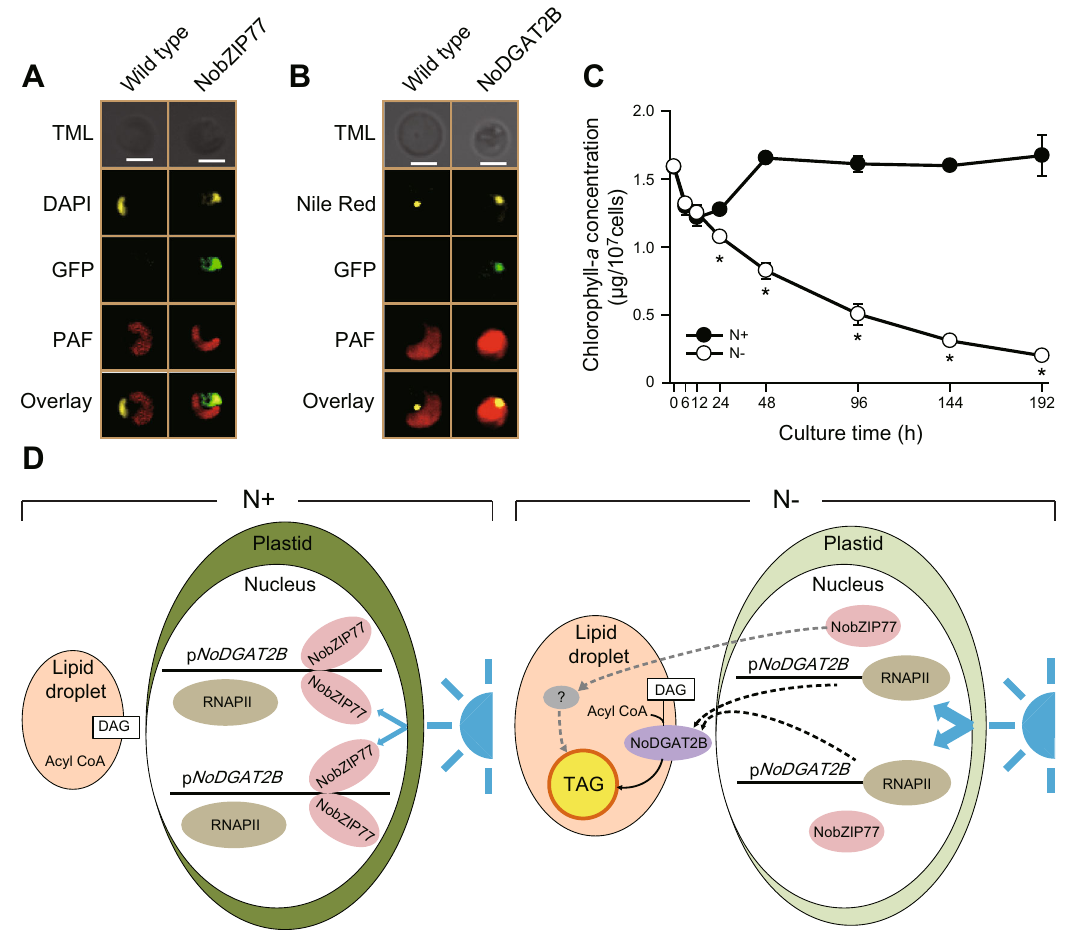
Fig. 4 A working model of nitrogen-depletion-induced TAG synthesis in Nannochloropsis oceanica . A , B Subcellular localization of NobZIP77 ( A ) and NoDGAT2B ( B ). GFP, green fl uorescent protein; TML, transmission light; DAPI, 4 ’ ,6-diamidino-2-phenylindole; PAF, plastid auto fl uorescence; scale bar, 2 μ m. The experiments were repeated three times. C Chlorophyll a levels in the N. oceanica WT under N + and N − . Data are represented as mean ± SD ( n = 3 biologically independent samples). *: signi fi cant change ( p ≤ 0.05) by one-sided Student ’ s t -test versus N + . D The proposed model, in which blue light promotes TAG production under N − , by inhibiting the binding between NobZIP77 and p NoDGAT2B (details described in “ Results ” ). RNAPII, RNA polymerase II; DAG, diacylglycerol; p NoDGAT2B , the NoDGAT2B promoter. Source data are provided as a Source data fi